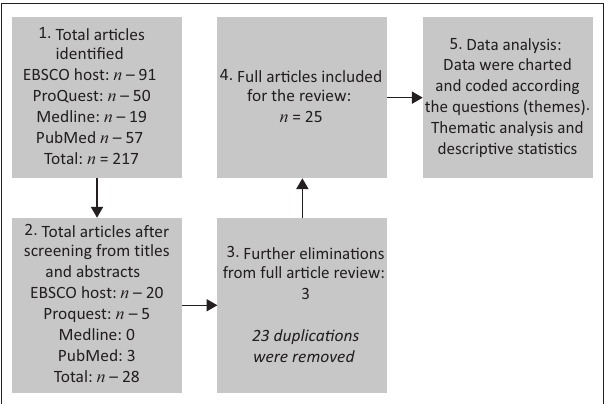
FIGURE 1 : Data collection